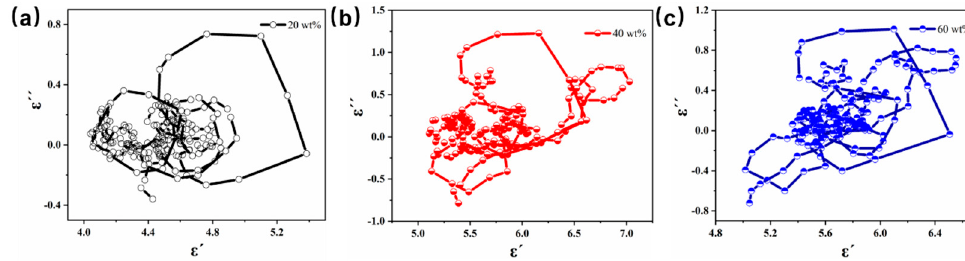
Figure 9. ε (cid:48) − ε (cid:48)(cid:48) plot of CIP@MnO 2 -paraffin sample with 20 wt% loading ( a ), 40 wt% loading ( b ), and 60 wt% loading ( c ). Table 1. Comparison of electromagnetic wave absorption properties of CIP@MnO 2 and its analogues.